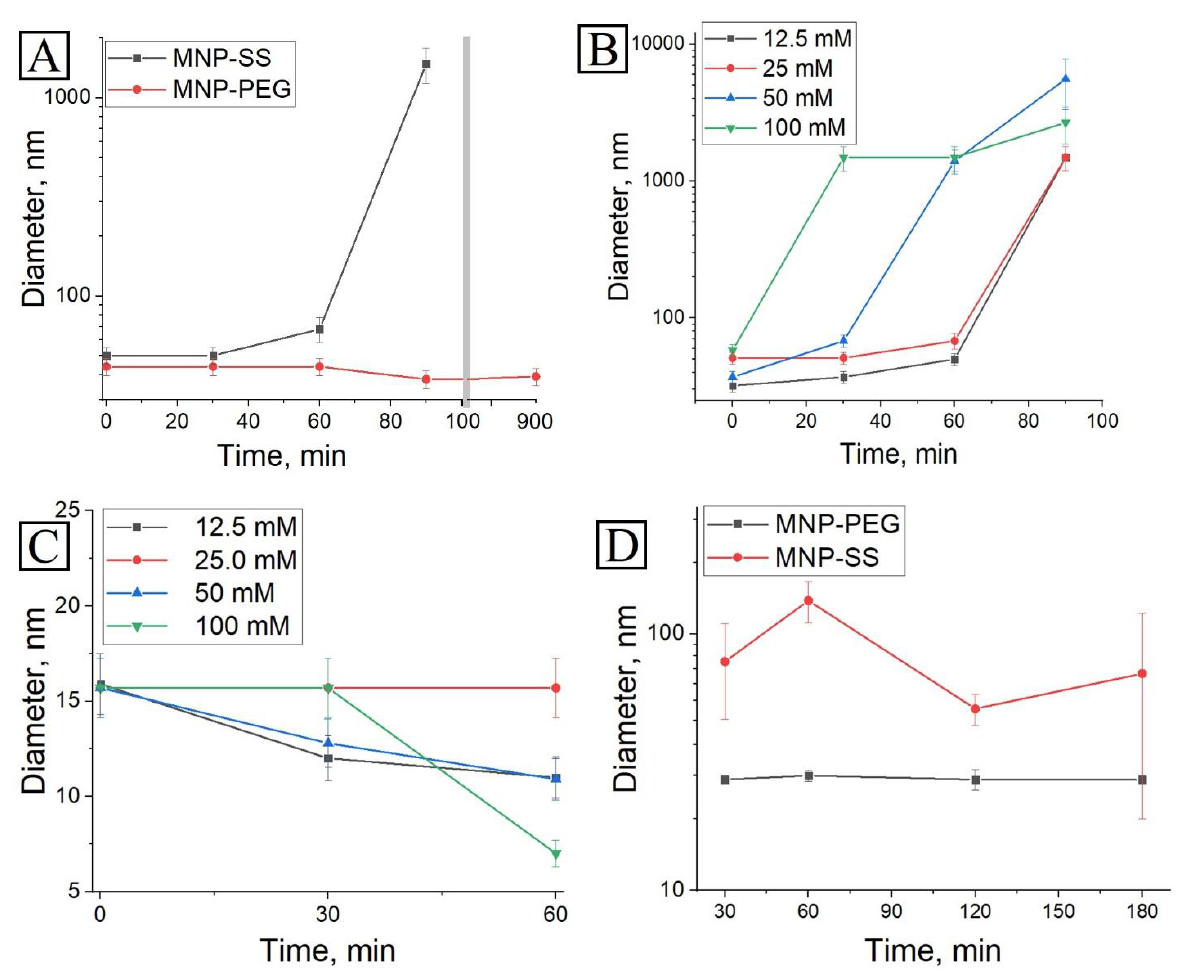
Figure 3. Measurement of hydrodynamic size dynamics in different conditions: ( A ) MNP-SS and MNP-PEG in PBS with pH = 7.4 and C (DTT) = 25 m; ( B ) MNP-SS in PBS with pH = 7.4 and C (DTT) = 12.5, 25, 50, or 100 mM; ( C ) MNP-SS in aqueous solutions of DTT with C (DTT) = 12.5, 25, 50, or 100 mM; ( A , D ) MNP-SS and MNP-PEG in conditioned medium after PC-3 cell culture growth.